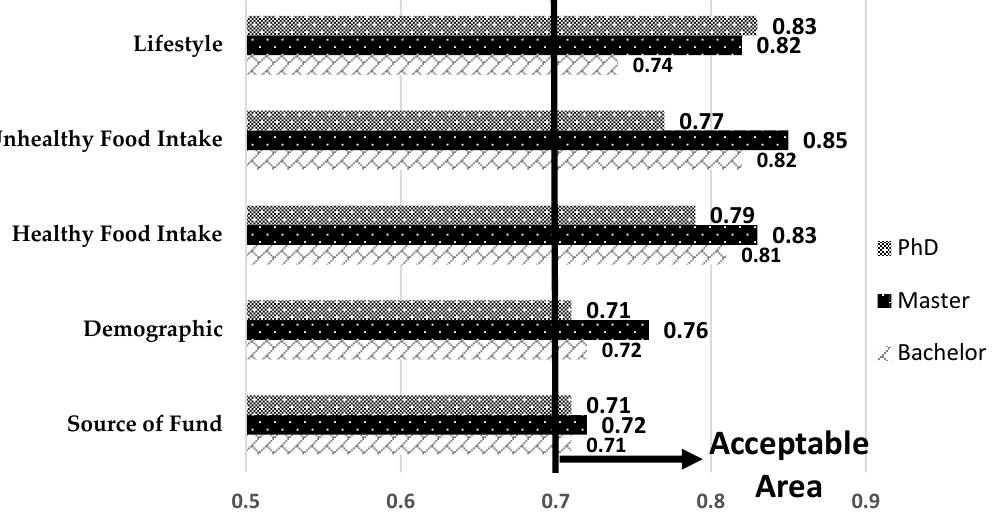
Figure 2. Cronbach’s alpha outputs.